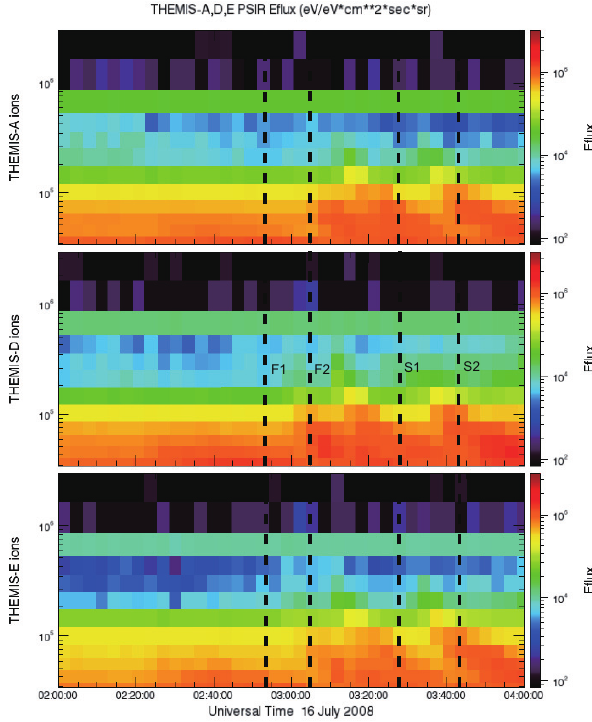
Fig. 10. Energetic electron injections observed by THEMIS-A, THEMIS-D and THEMIS-E probes from 02:00UT to 04:00UT on 16 July 2008. The vertical dashed lines denote ground Pi2 onsets.